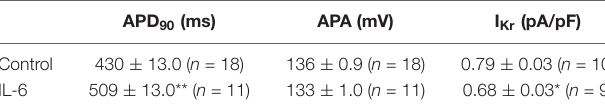
APD 90 , action potential duration at 90%; APA, action potential amplitude; I Kr , rapid delayed rectifier current. IL-6 was used at the concentration of 200 µ g/L. All values are expressed as mean ± SE. The number of experiments performed is indicated by “n = .” The unpaired t-test was used to compare data regarding IL-6 for AP, APA, and I Kr with control. *P < 0.05, **P < 0.01 vs.